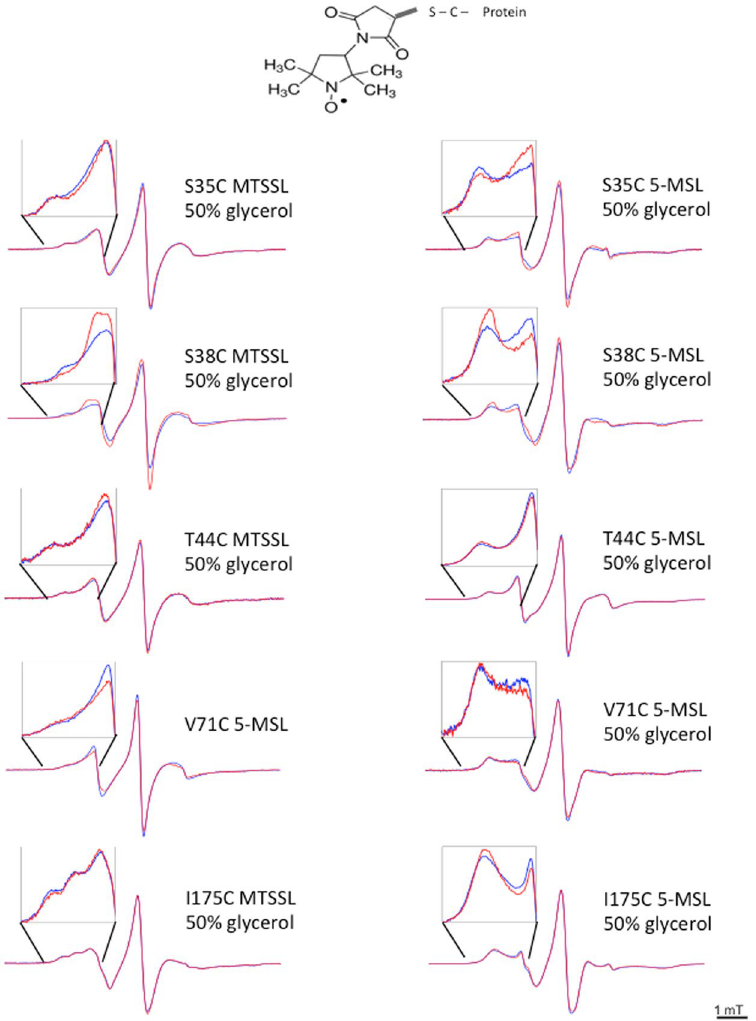
Figure 5. CW-EPR spectra of some HydF mutants labeled with either MTSSL (50% v/v glycerol) or 5-MTS (in the presence or in the absence of 50% v/v glycerol) taken before (blue) and immediately after (red) addition of GTP. For each mutant, an enlargement of the low-field region is shown. Spectra are taken at room temperature.